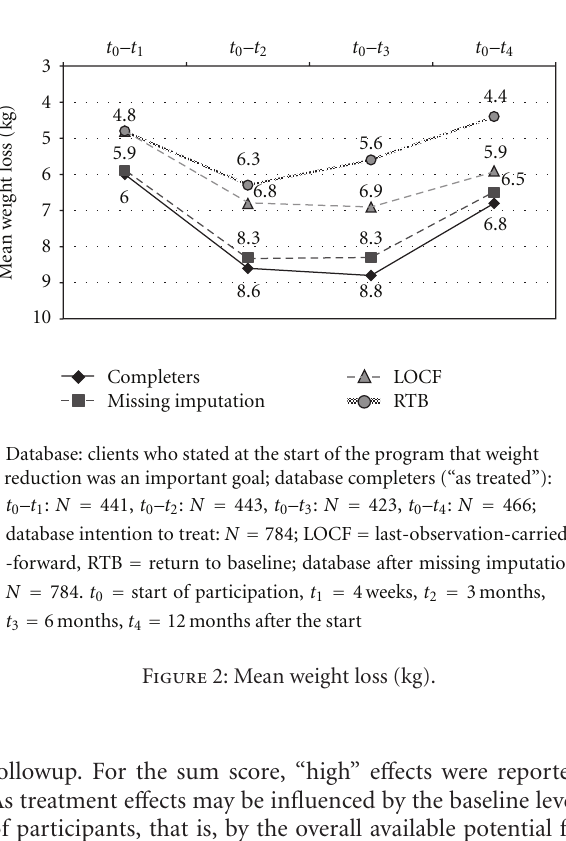
Figure 2: Mean weight loss